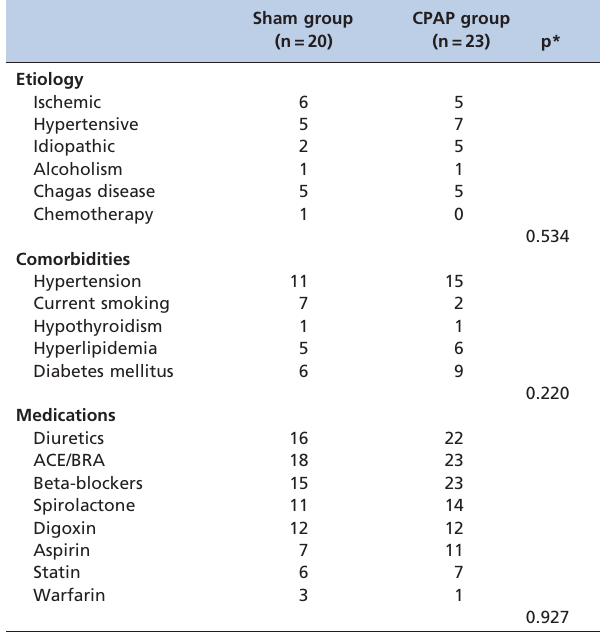
Table 2 - Etiologies and